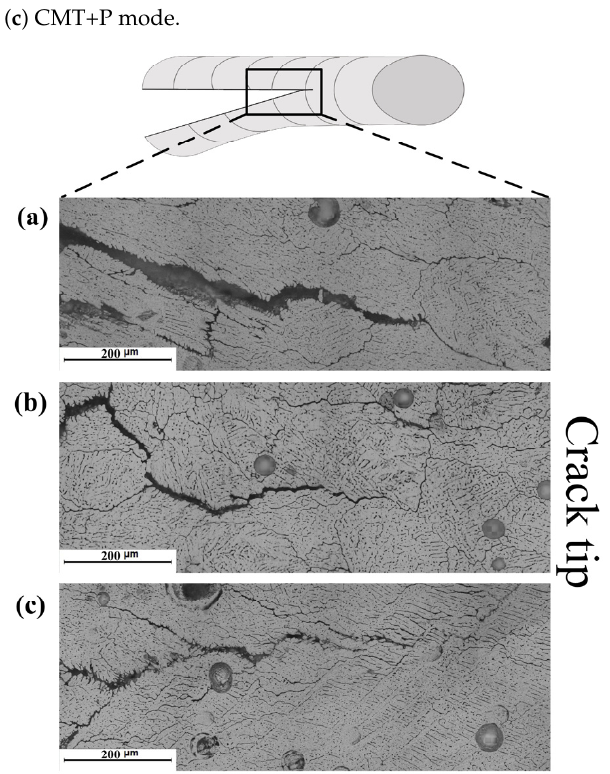
Figure 15. Crack tip of 7075 Al welded with 7150 Al as filler metal: ( a ) MIG mode; ( b ) CMT mode; ( c ) CMT+P mode.